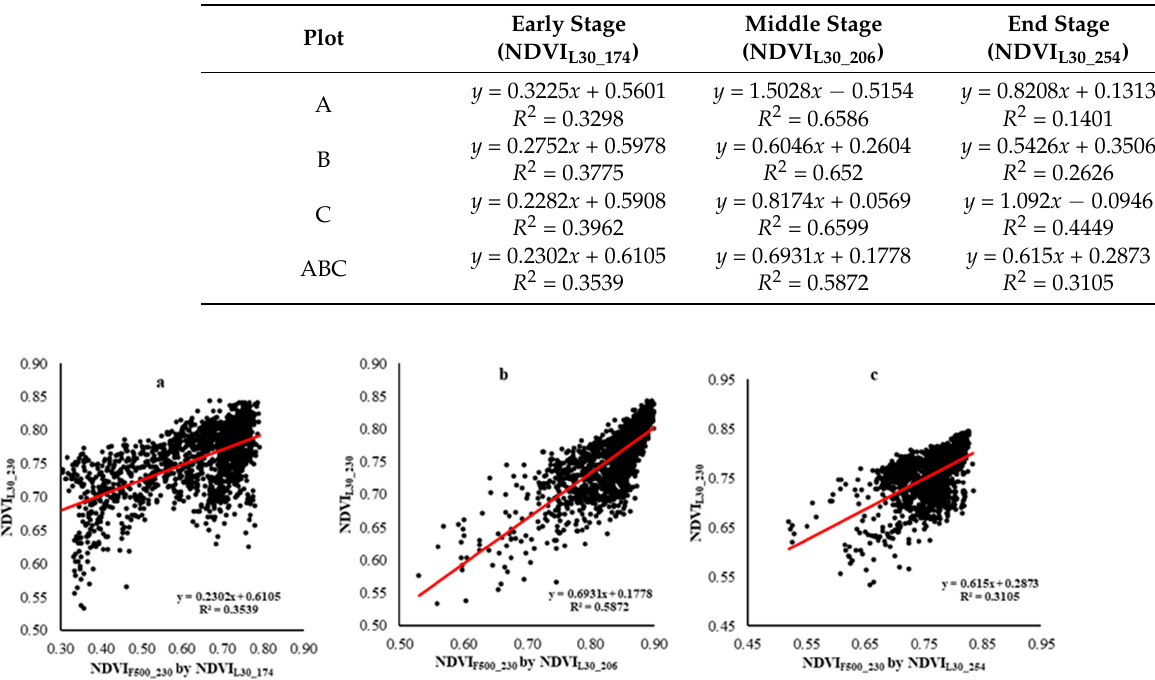
Figure 11. Scatterplots showing the relationship between the fusion products NDVI F500 and NDVI L30 ; NDVI L30_230 versus NDVI F500_230 using ( a ) NDVI L30_174 , ( b ) NDVI L30_206 , and ( c ) NDVI L30_254 for all pixels of 3 plots). Table 2. Results of linear regression between the fusion product NDVI F500_230 using different refer- ence dates and NDVI L30_230 in 3 plots.